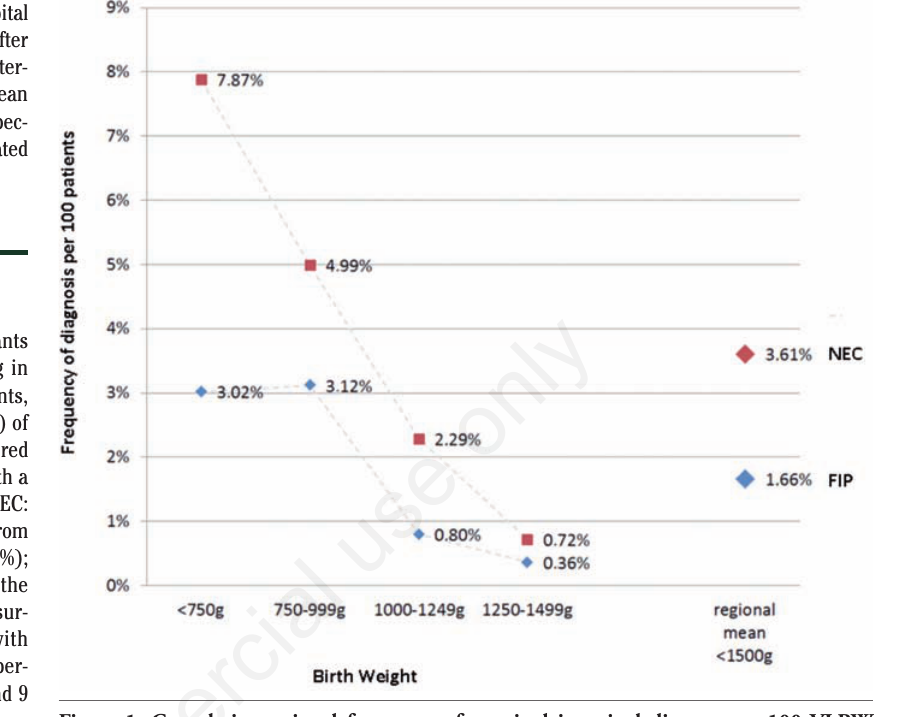
Figure 1. Cumulative regional frequency of acquired intestinal diseases per 100 VLBW infants in Baden-Württemberg in the years 2010 to 2012. Patients were stratified by birth weight in intervals of 250 g each. In all birth weight strata, rates of necrotizing enterocoli- tis (NEC) are at least twice as high as the rates of focal intestinal perforation